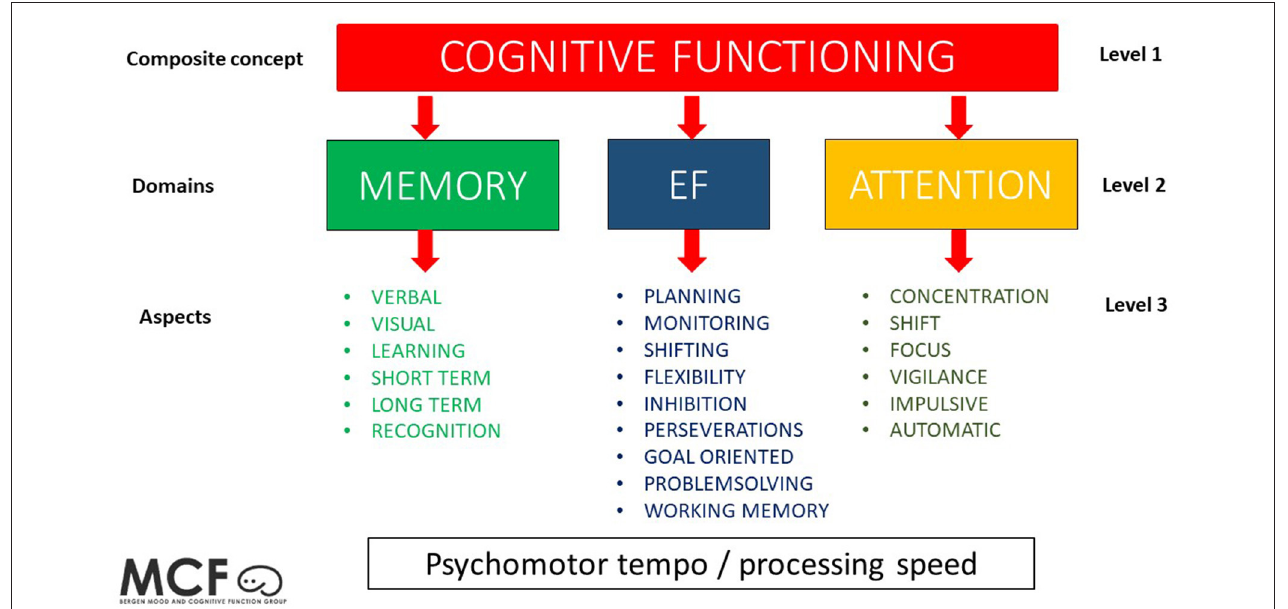
FIGURE 2 | This figure shows a conceptual model of the levels of cognitive functioning, with cognitive functioning as a composite concept (level 1) having three major sub-concepts as domains (level 2) and several specific aspects within each domain (level 3). In this model, psychomotor tempo/processing speed is illustrated as interrelated with all the other